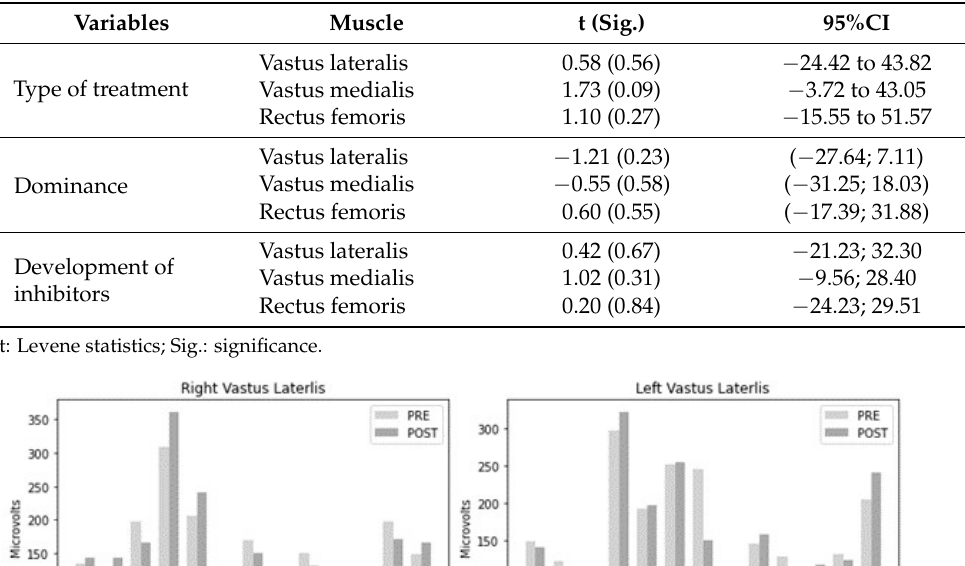
Table 4. Changes according to the degree of hemophilia severity, type of treatment, and development of inhibitors.